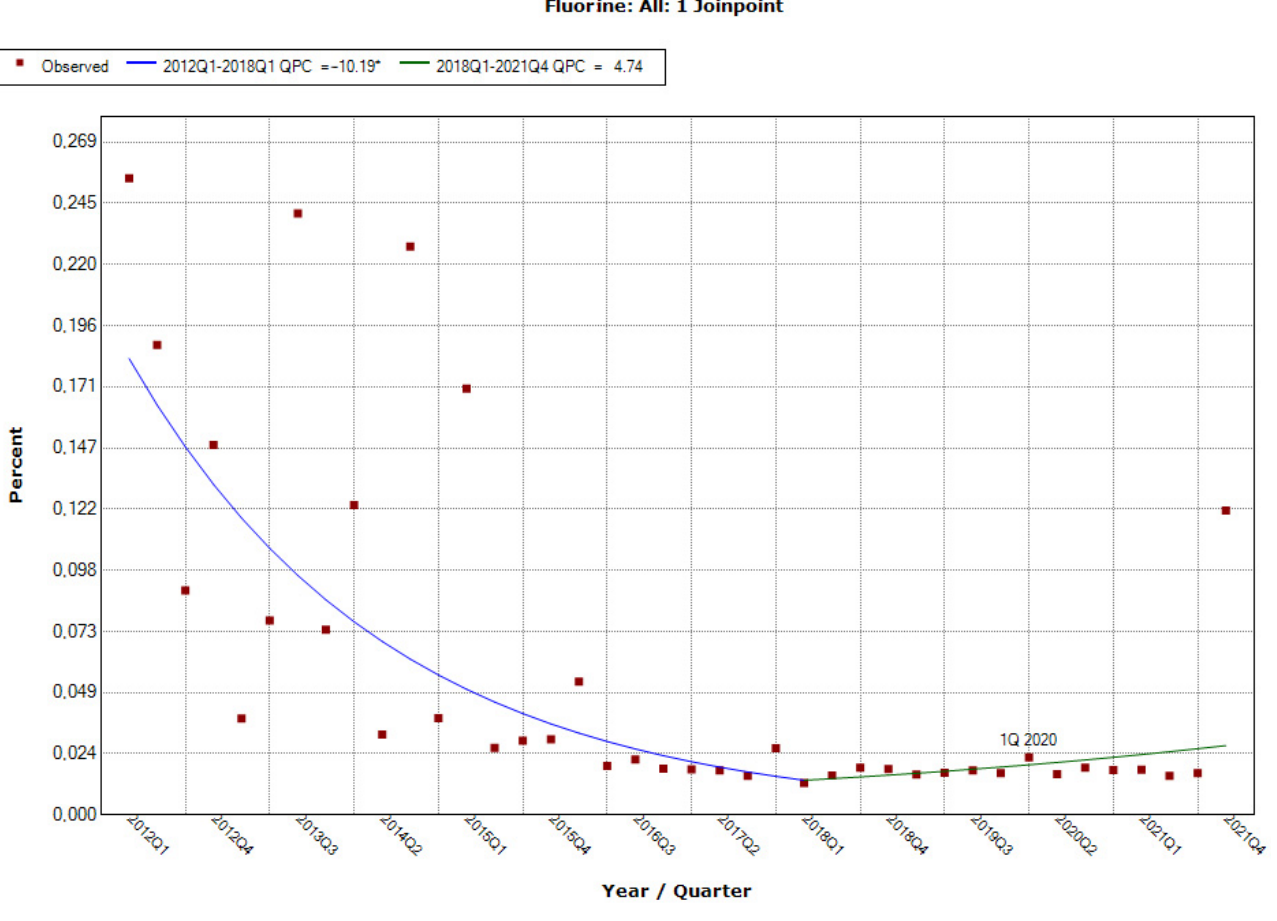
Figure A18. Percentage of products containing fluorine in individual quarters in the period from 2012 to 28 November 2021. Joinpoints mark trend turning points. The date above the observation indicates the moment of publication of the scientific opinion/resolution.